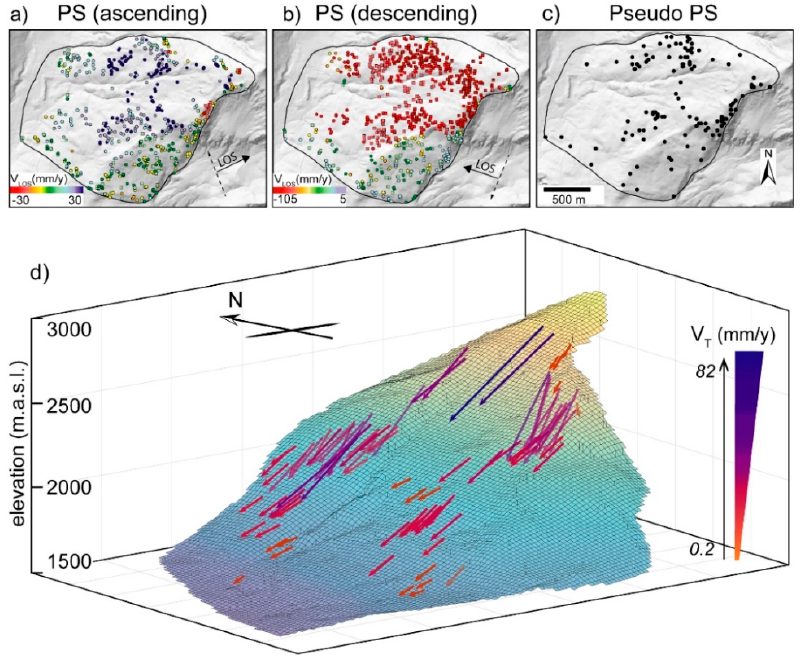
Figure 3. Kinematics of the Mt. Mater DSGSD derived from SqueeSAR TM data analysis. ( a,b ) permanent (PS) and distributed scatterers (DS), classified by line-of-sight (LOS) displacement rate ( V LOS ); ( c ) pseudo-PS derived by combining data from ascending and descending orbit; ( d ) 3D visualization of the 2D total displacement vector T , derived by the 2D decomposition of LOS velocities at pseudo-PS locations. Vector color and length are classified by T vector velocity ( V T ).